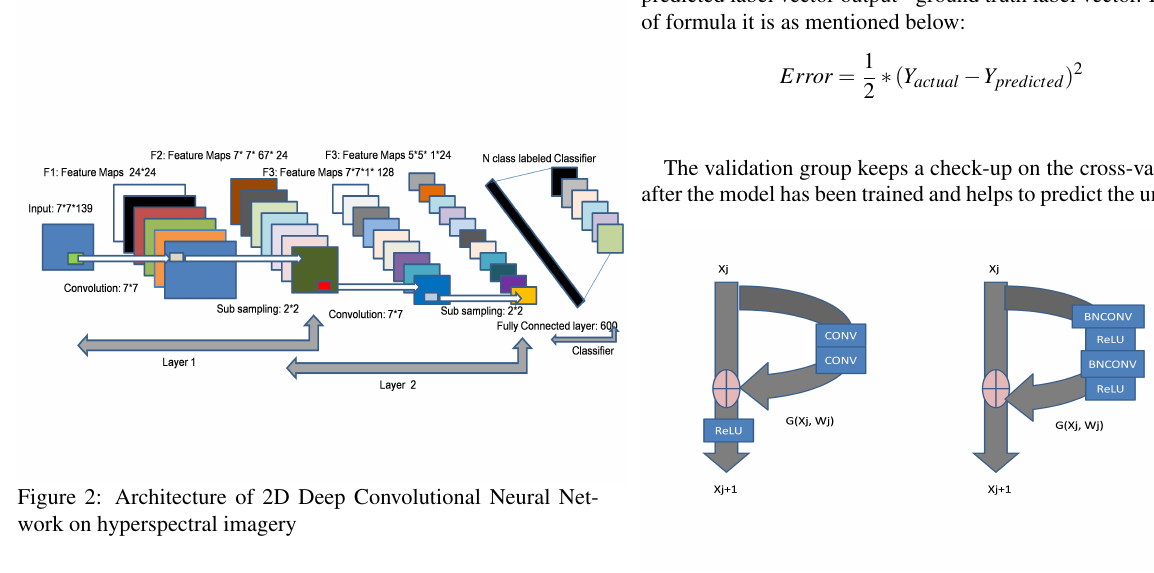
Figure 3: Basic Architectural residual blocks. Residual frame- work without batch normalization (left) and with batch normal- ization